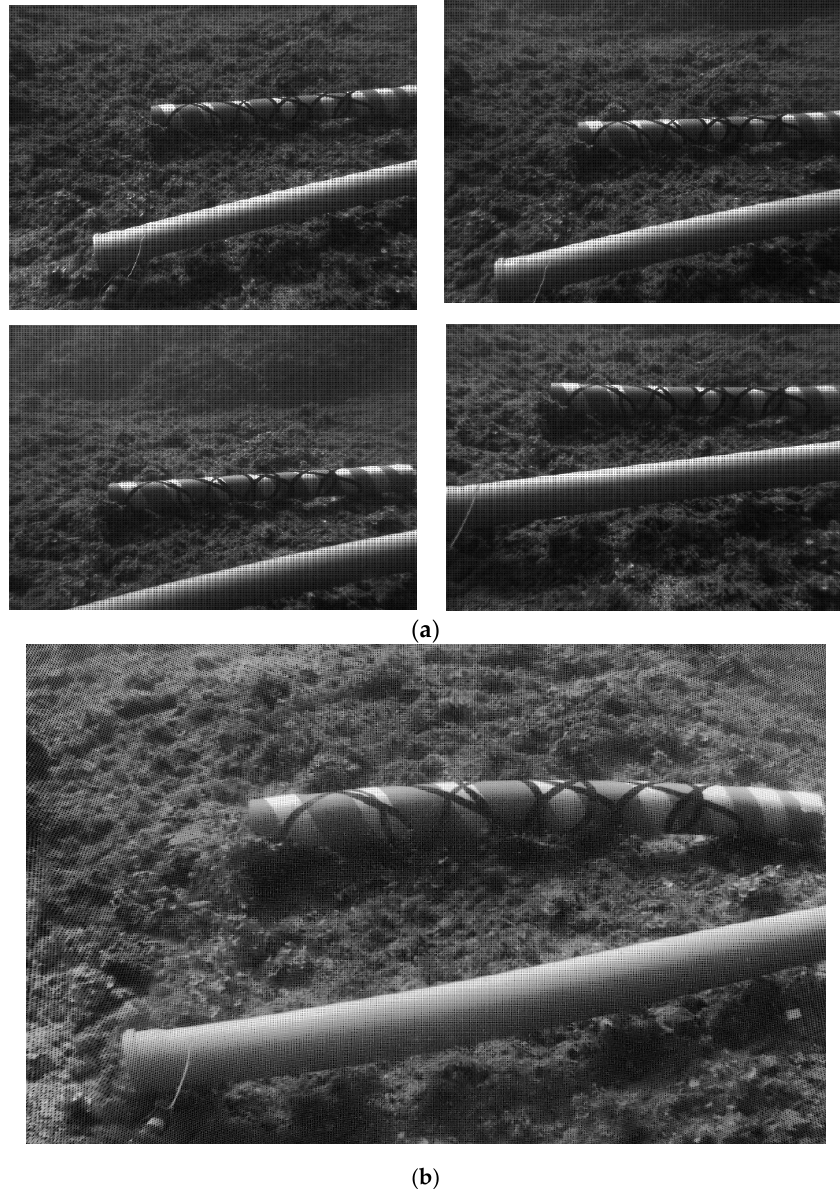
Figure 8. Mosaic image of underwater pipe dataset for every 20 frames ( a ) original images and ( b ) final mosaicked image.